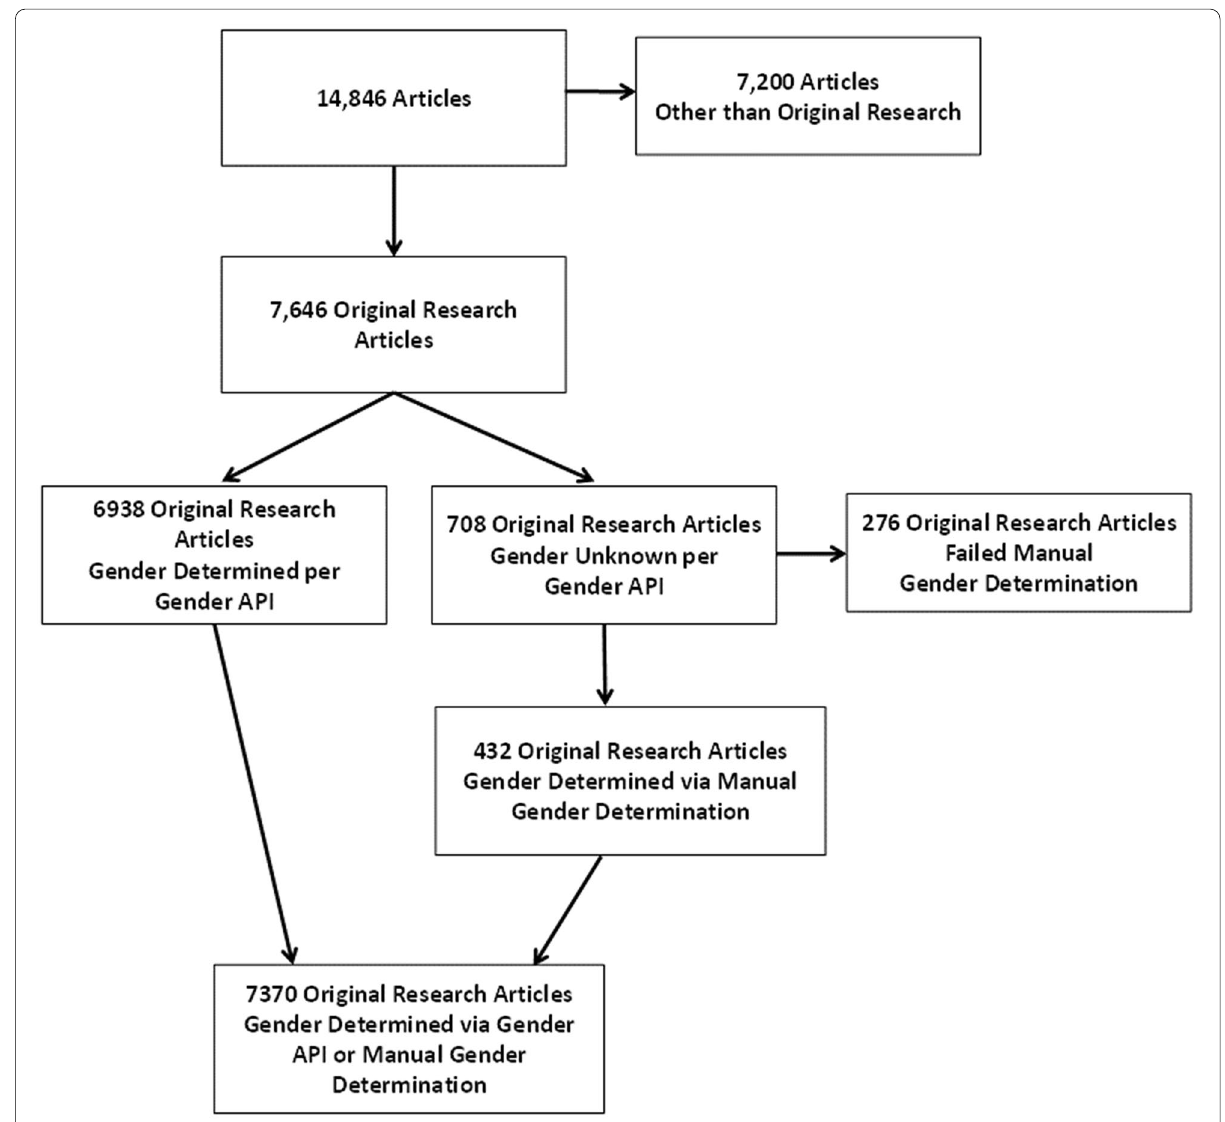
Fig. 1 Flowchart of Authorship Gender determination of original